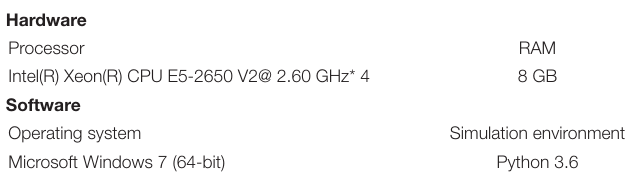
TABLE 1 | Experimental